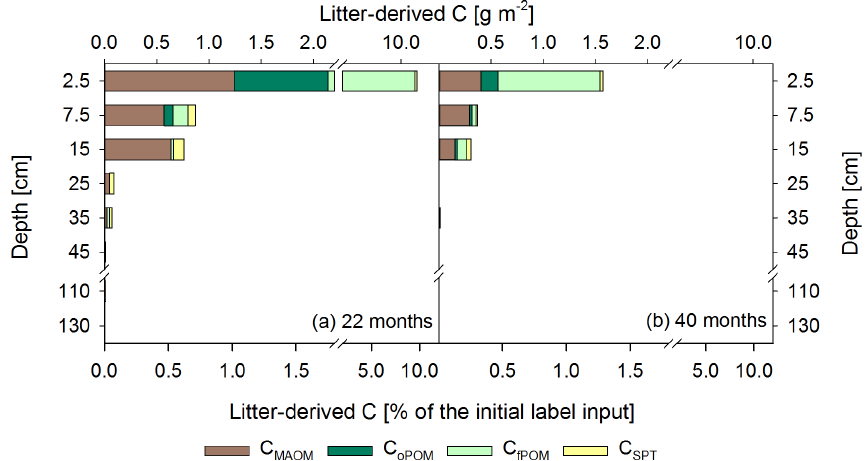
Figure 6. Mean labeled litter-derived 13 C recovered in different OM fractions: C in mineral-associated OM (C MAOM ), occluded particulate OM (C oPOM ), and free particulate OM (C fPOM ); C mobilized by sodium polytungstate during density fractionation (C SPT ). The upper x axis shows the recovered 13 C in gm − 2 , and the lower x axis shows the percentage recovery of initially added labeled litter after 22 months (a) and 40 months following labeled litter application (b) . Bars show the sum of all fractions per depth increment, while the different colors represent the respective contribution of each fraction to the total recovery ( n = 3). According to ANOVA tests there were no significant changes in 13 C recovery for each fraction with depth per sampling, due to high standard deviations in the range of 0.02–0.53 for C MAOM , 0.01–0.75 for C oPOM , 0.02–4.9 for C fPOM , and 0.01–0.13 for C SPT